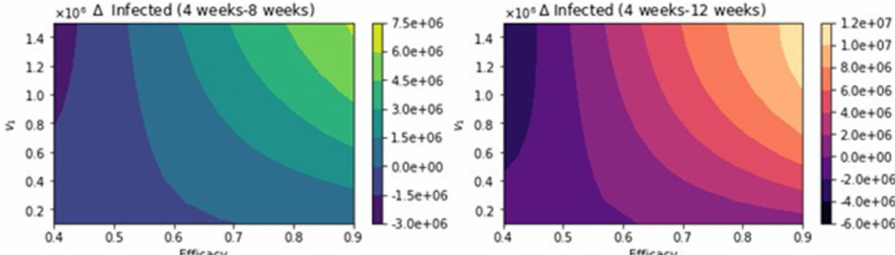
Figure 11. Differences between the total number of infected for the different vaccination regimens, and under a variety of vaccine efficacies after the first dose and different vaccination rates per day. The basic reproduction number R 0 >